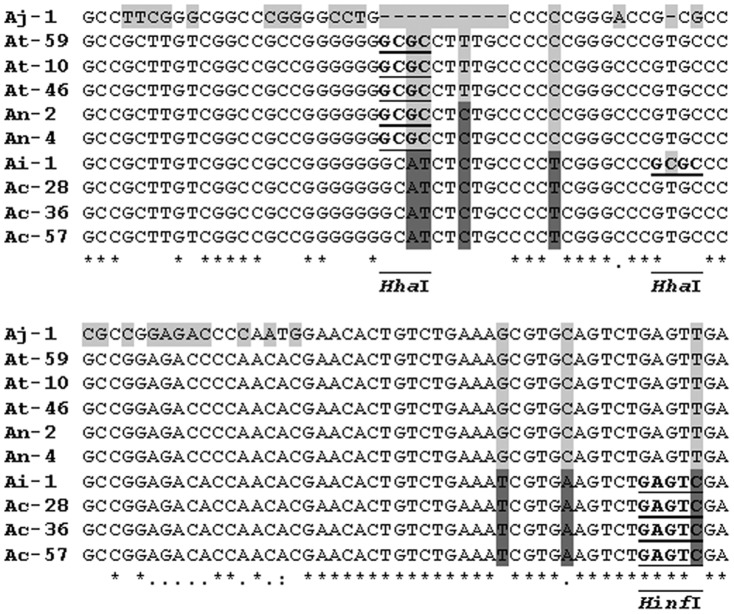
Alignment of the ribosomal 5.8S-ITS amplicon sequences of representative Aspergilli isolates.A part of the amplicon sequences (nucleotides 101 to 200) alignment is presented. Restriction sites are presented as bold-underlined, and variable nucleotides are highlighted. The extra HhaI restriction site present in the Ai-1 sequence is also shown.